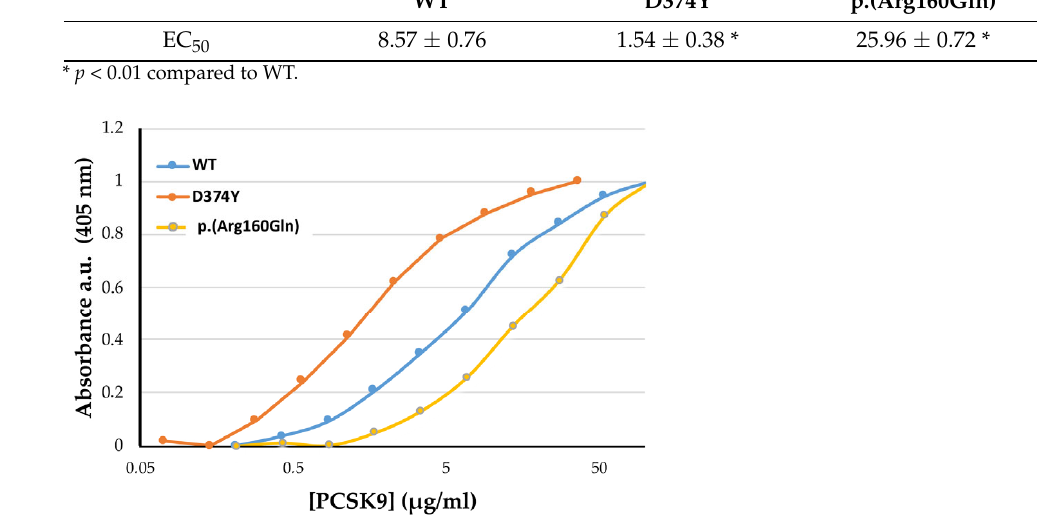
Figure 4. The p.(Arg160Gln) PCSK9 variant shows lower affinity to the LDLr compared to WT. Affinity curves representing the binding affinity of PCSK9 variants for the LDLr determined by solid-phase immunoassay at pH 7.4. Data represents the means of three independent experiments. EC 50 values are shown in Table 3.